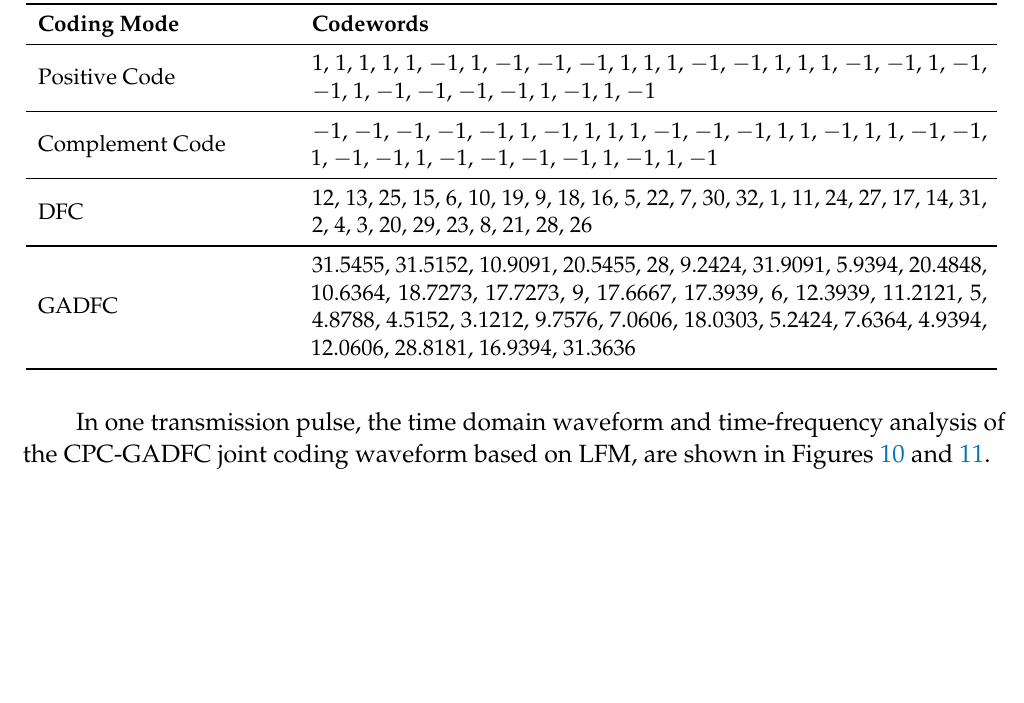
Table 2. Complementary Code, DFC Sequence and GADFC Sequence